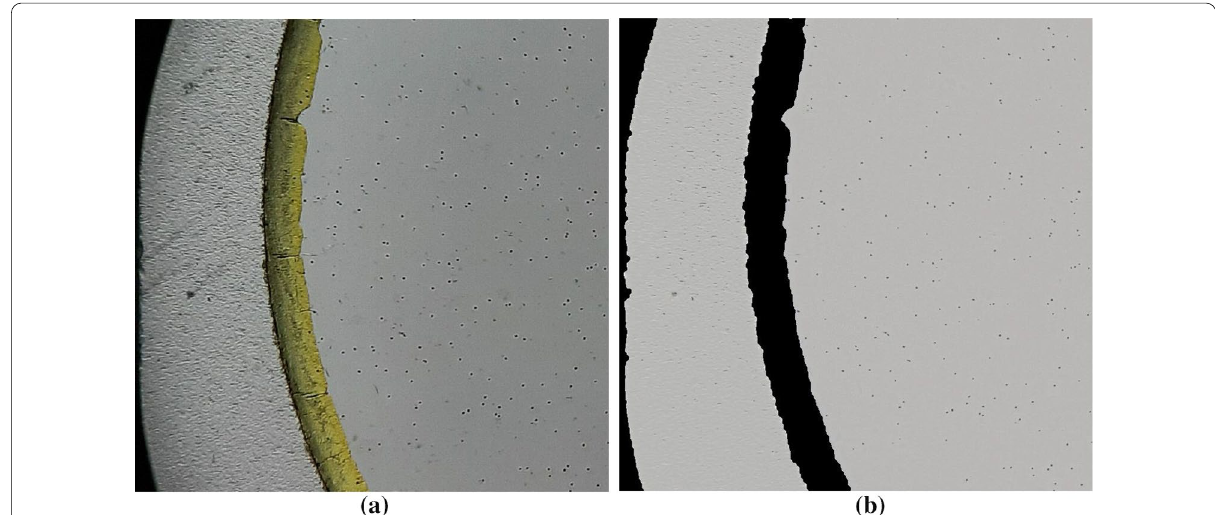
Fig. 1 a Original image acquired with a cell phone through the stereo microscope eyepiece; b the same image after being pre-processed and